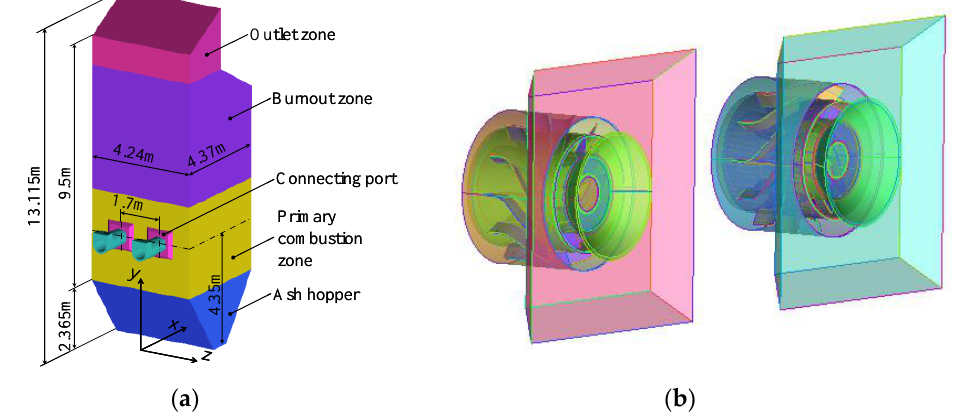
Figure 1. Schematic diagram of swirl burner. ( a ) Structure of swirl burner; ( b ) Vane geometry.